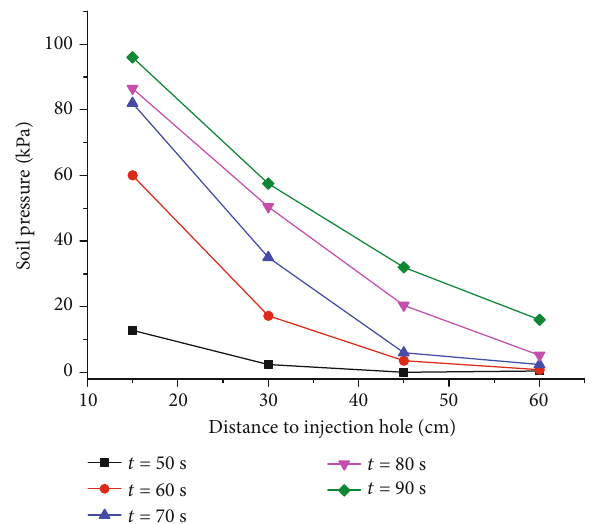
Figure 10: Spatial distribution of soil pressure at di ff erent pressure changes, part of the pressure data between adjacent grouting stages is omitted in data curves. Variation of soil pressure with time in three grouting stages is shown in Figure 11. For convenient comparison, pressure data in Figure 11 all comes from pressure sensors with a distance to the injection hole of 15 cm.